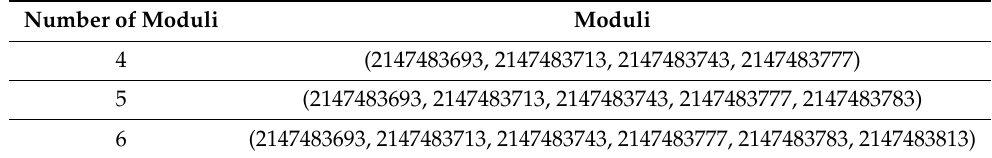
Figure 8. Redundancy.